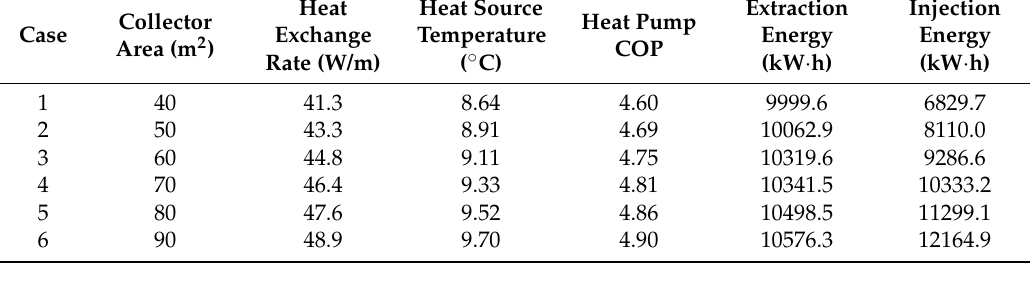
Figure 10. Difference of performance value between the two systems.